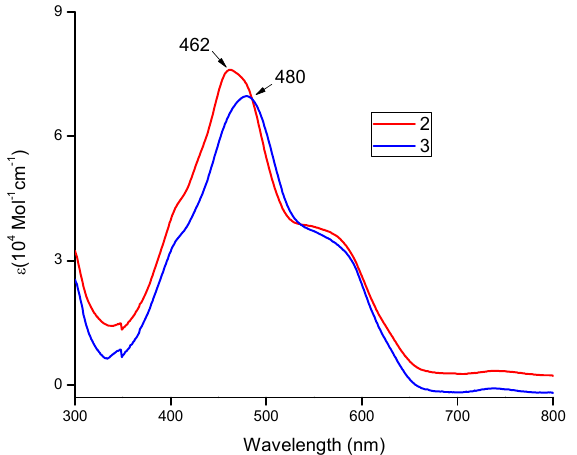
Figure 2. UV-Vis spectra of rosarrin 3 (blue line) and rosarrin 2 (red line) in CH 2 Cl 2 . Figure 2. UV ‐ Vis spectra of rosarrin 3 (blue line) and rosarrin 2 (red line) in CH 2 Cl 2 . Such a larger shift is unique in these classes of macrocycles considering the fact that the meso -substituents adopt nearly orthogonal conformation against the rigid macrocyclic core. For instance, peripherally modified rosarrin analogues displayed minimal changes in absorption spectra compared to the parent rosarrin 2 [10,11]. We envisaged that macrocycle core possesses a modified dioxine ring at meso position which alters its dihedral angle and results such a bathochromic